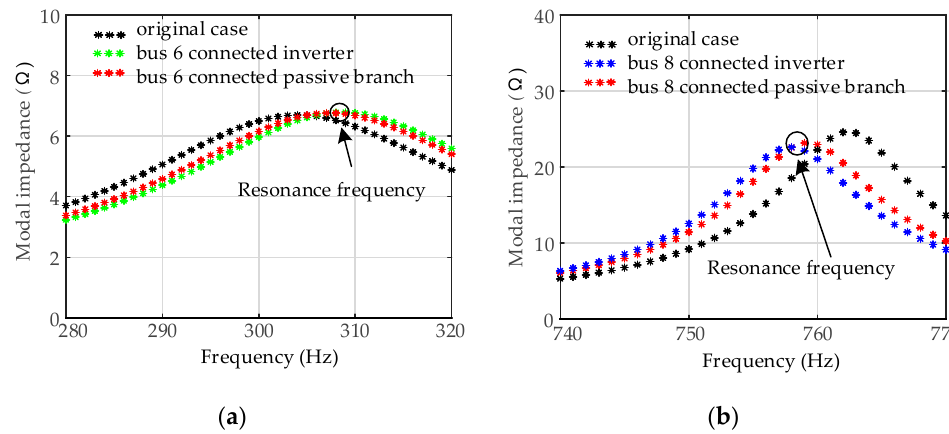
Figure 9. Effect of components on the resonance mode of: ( a ) f = 305 Hz; ( b ) f = 760 Hz.